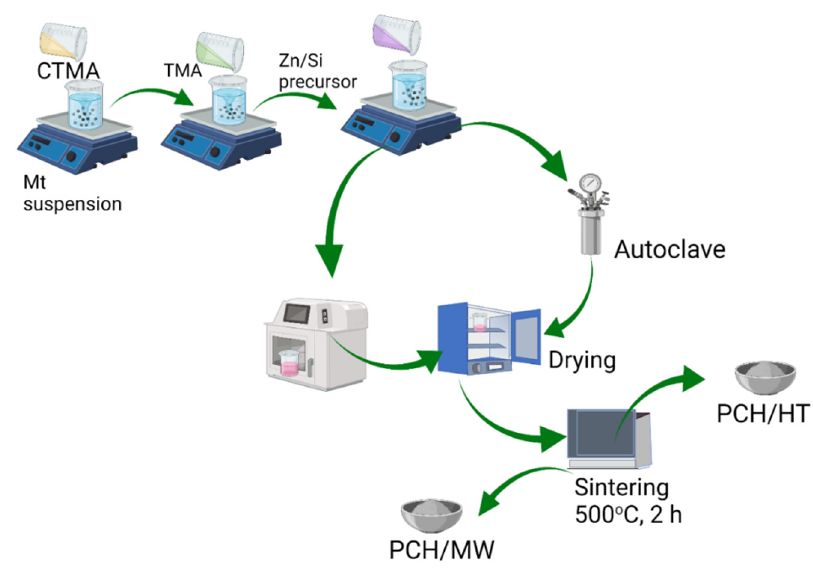
Figure 1. Schematic representation of ZnO 2 /SiO 2 ‐ PCH synthesis.